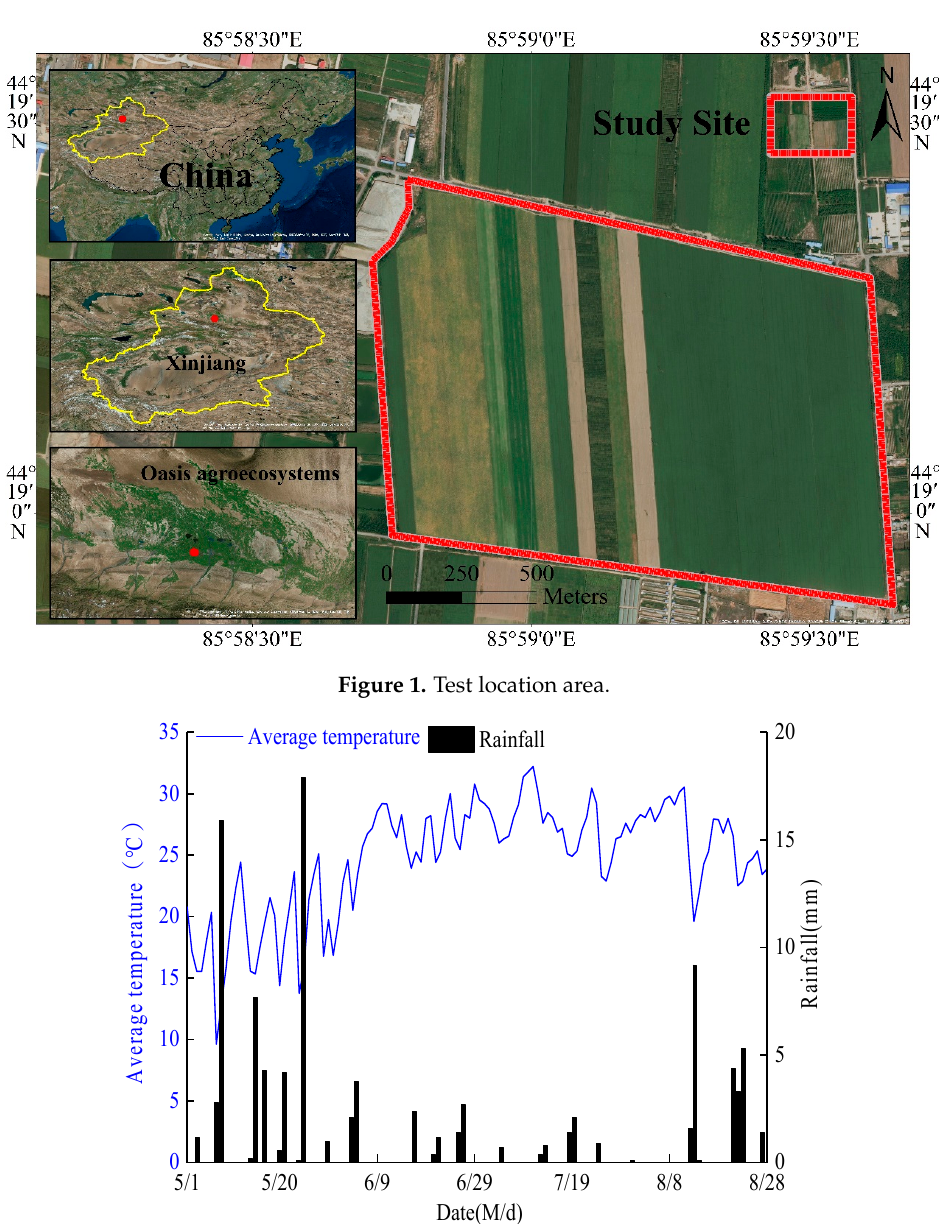
Figure 2. Daily average temperature and rainfall during the maize growth period.